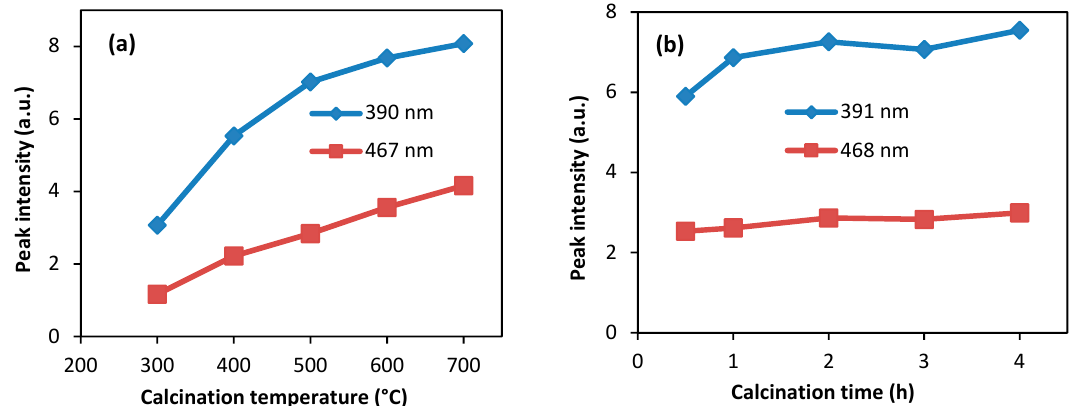
Figure 9. Changes of relative intensity with ( a ) different calcination temperatures and ( b ) different calcination times.